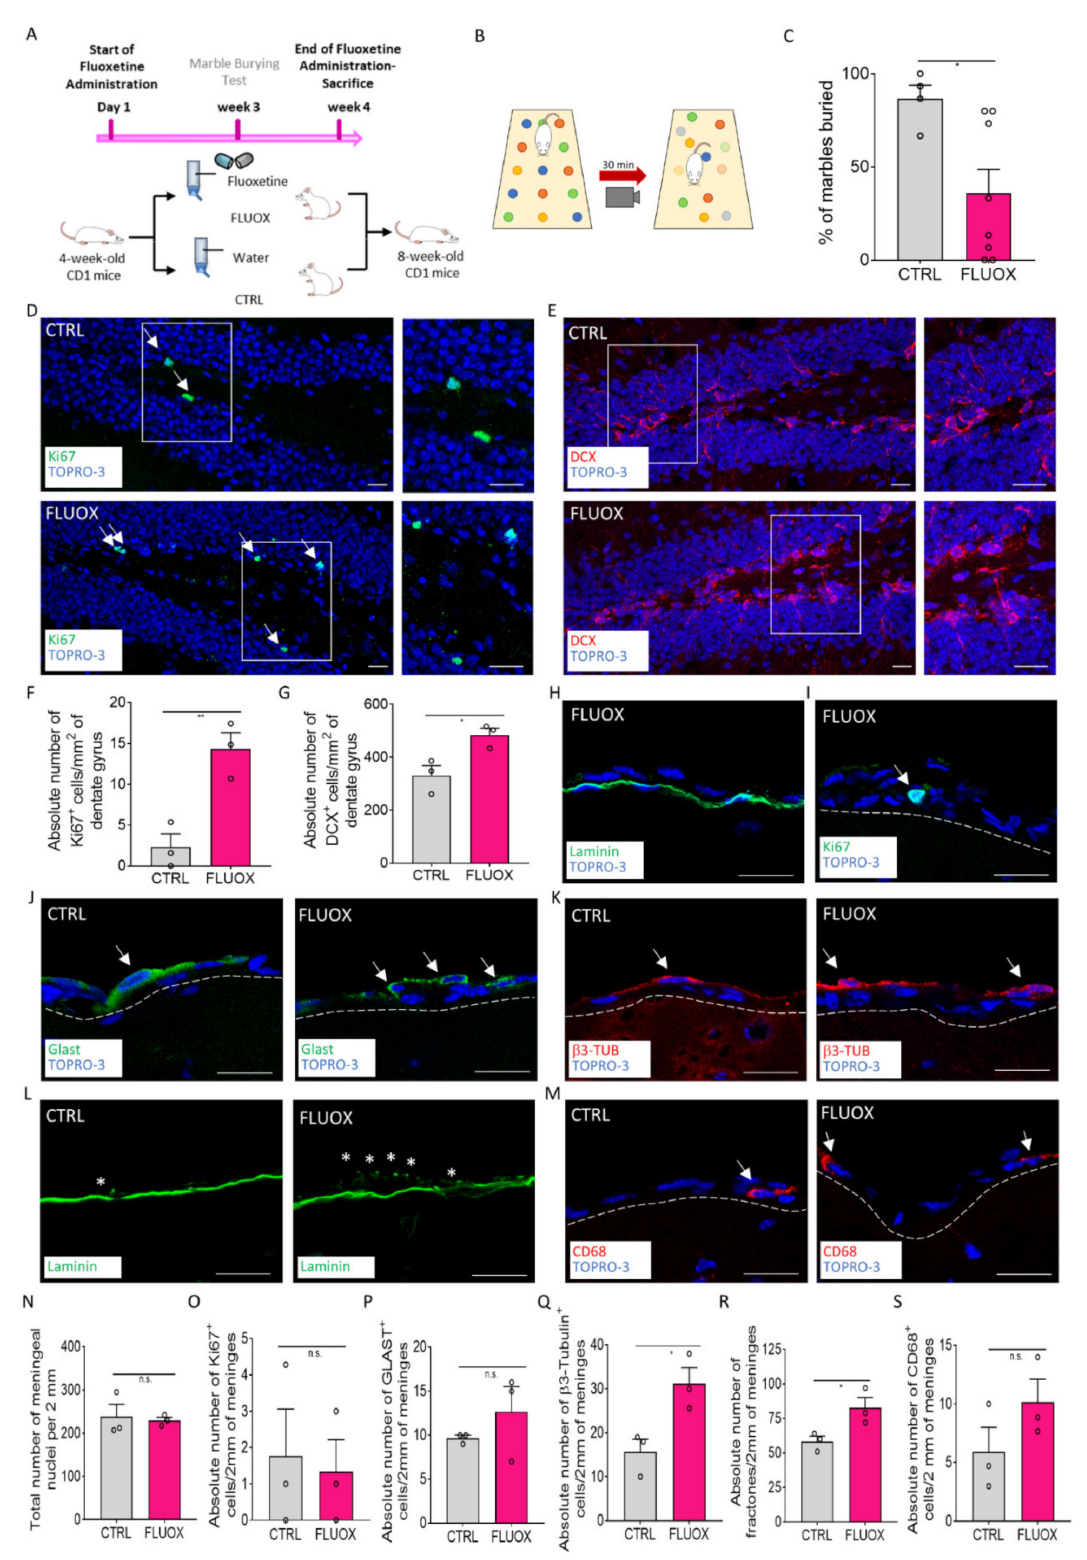
Figure 5. The meningeal niche responds to fluoxetine treatment. ( A ) Schematic representation of the experimental design used for fluoxetine administration. ( B ) Schematic representation of behavioral testing for OCD-like behavior via the marble burying test (MBT). ( C ) Graph showing the percentage of marbles buried by treated (FLUOX) and non-treated (CTRL) animals. ( D , E ) Sagittal brain sections of the CD1 mice, showing the presence of Ki67 + cells (green) and DCX + cells (red) in the hippocampal dentate gyri (DGs) in the CTRL and FLUOX animals. A white box highlights a DG zone reported as